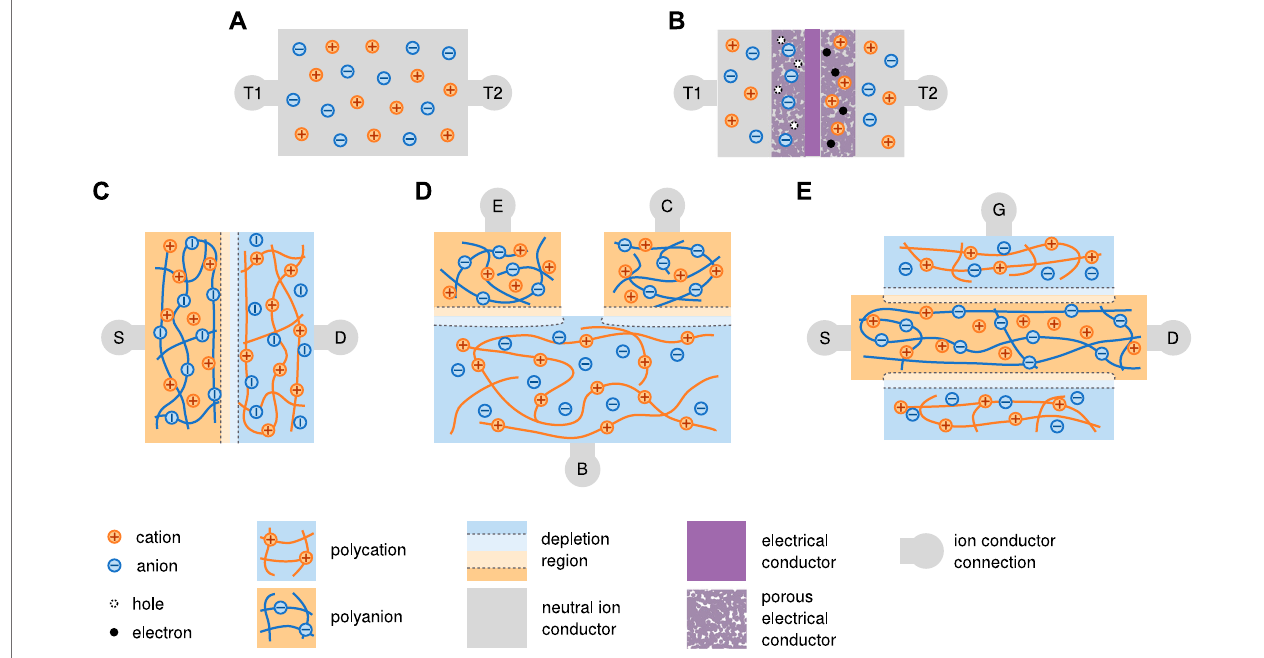
FIGURE6| Schematicsofionicsignal transmutation approaches. Video animationsoftheoperationofdevicesB,D, and Eare included in theSIand on YouTube. (A) Polyelectrolyte resistor from a generic ion conductor with symmetric terminals T1 and T2. (B) Inverted supercapacitor in a charged state with T1 at a lower voltage than T2 (C) Type III PN Polyelectrolyte diode with source (S) and drain (D) ionic connections. Current can fl ow from left to right, but not from right to left. (D) PNP Bipolar Junction Transistor (BJT) with emitter (E), collector (C), and base (B). The current through the gate controls the current fl owing from source to drain. (E) P-channel Junction Field Effect Transistor (JFET) with source (S), drain (D), and gate (G). Increasing reverse bias of the base-to-channel junction reduces the current from source to drain. (F) Legend for all